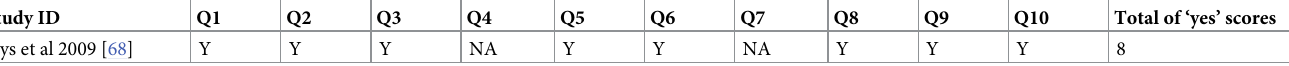
Table 5. Summary score for methodological quality of case series